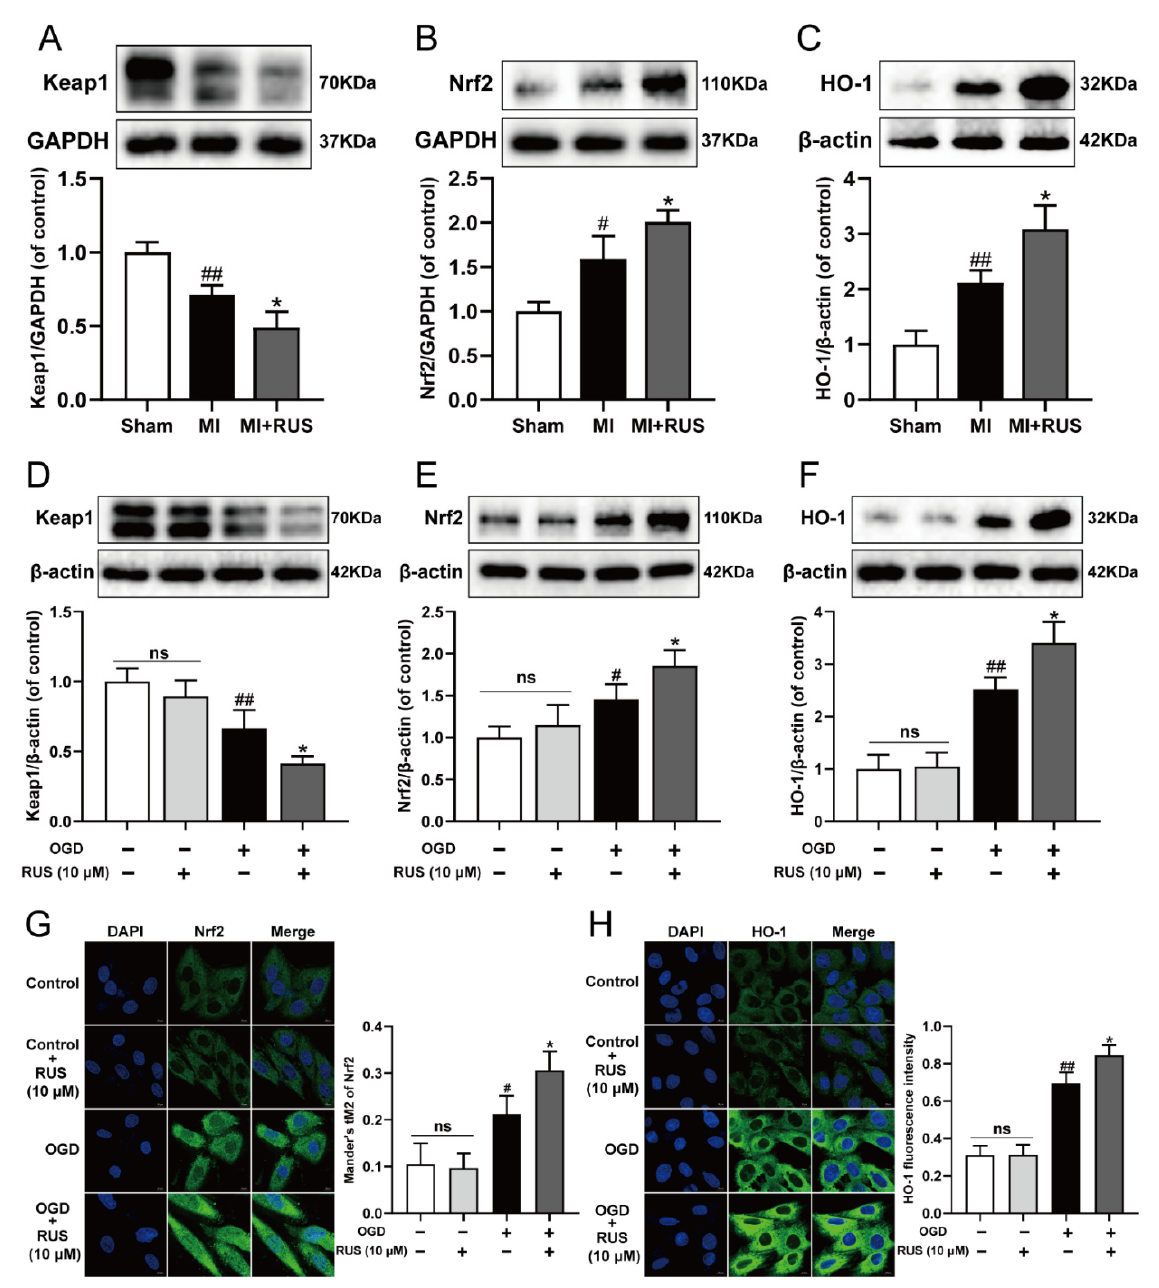
Figure 7. RUS significantly activated the Keap1/Nrf2/HO-1 signaling pathway in MI. Western blotting analysis of ( A ) Keap1, ( B ) Nrf2 and ( C ) HO-1 in the heart tissues of sham, MI and MI treated with 0.75 mg/kg RUS groups ( n = 3). Western blotting analysis of ( D ) Keap1, ( E ) Nrf2 and ( F ) HO-1 in H9c2 cardiomyocytes ( n = 3–4). Immunofluorescence images of ( G ) Nrf2 and ( H ) HO-1 in H9c2 cardiomyocytes (scale bar, 10 µm, n = 3). Results were expressed as mean ± SD. # p < 0.05, ## p < 0.01 vs. the sham or control group, * p < 0.05 vs. the MI or OGD group.